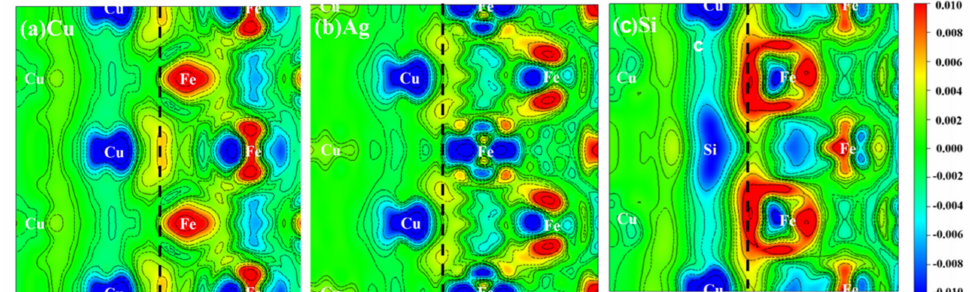
Figure 3. Di ff erence charge density (e / Å 3 ) of Cu / γ –Fe interface. ( a – c ) represent no solute atom, a solute atom Ag and Si, respectively. The dashed lines indicate the location of the interfaces. Areas of electron accumulation (red) and depletion (blue) have positive and negative signs, respectively; contour lines are drawn at 0.002 e / Å 3 intervals.